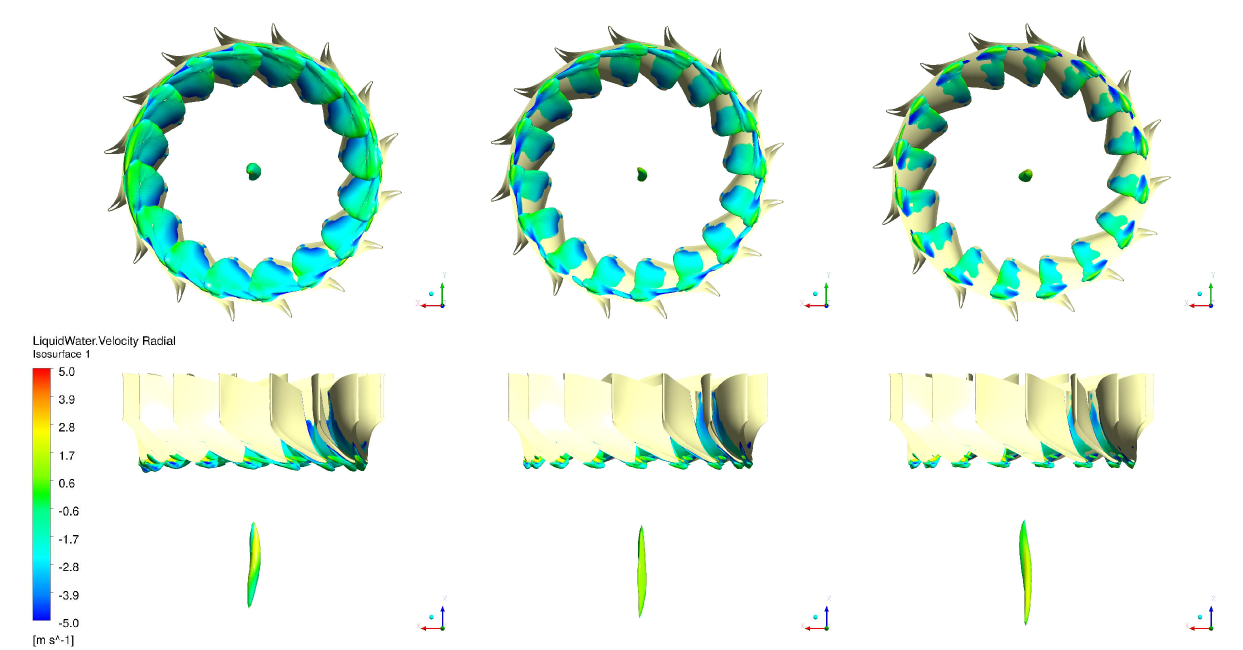
Figure 3. Instantaneous iso-surface of the liquid volume fraction α L = 0.9. Downstream view (top) and side view